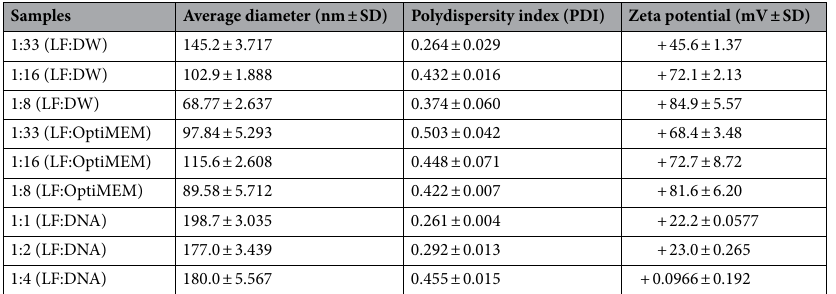
Table 1. Hydrodynamic size (diameter) and zeta potential of different mixing ratios of dilution of LF and LF to DNA in Opti-MEM medium. Data are addressed as mean ± SD, n =